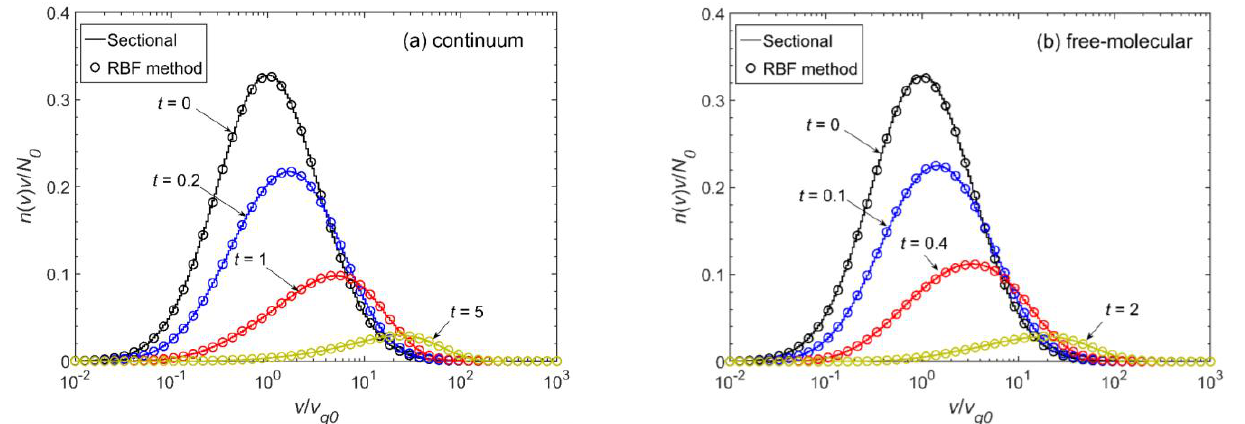
Figure 3. Comparison of the RBF and the sectional methods for predicting the temporal evolution of particle size distributions: ( a ) Brownian coagulation under the continuum regime; ( b ) Brownian coagulation under the free-molecular regime. The solid lines are predictions obtained using the sectional method and the circle symbols are predictions obtained using the RBF method.